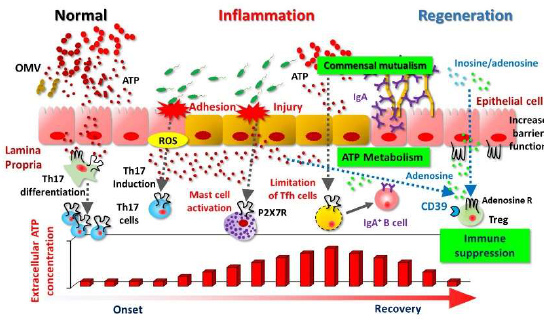
through which extracellular ATP (eATP) mediates communication between bacteria and host immune cells in the intestinal compartment are